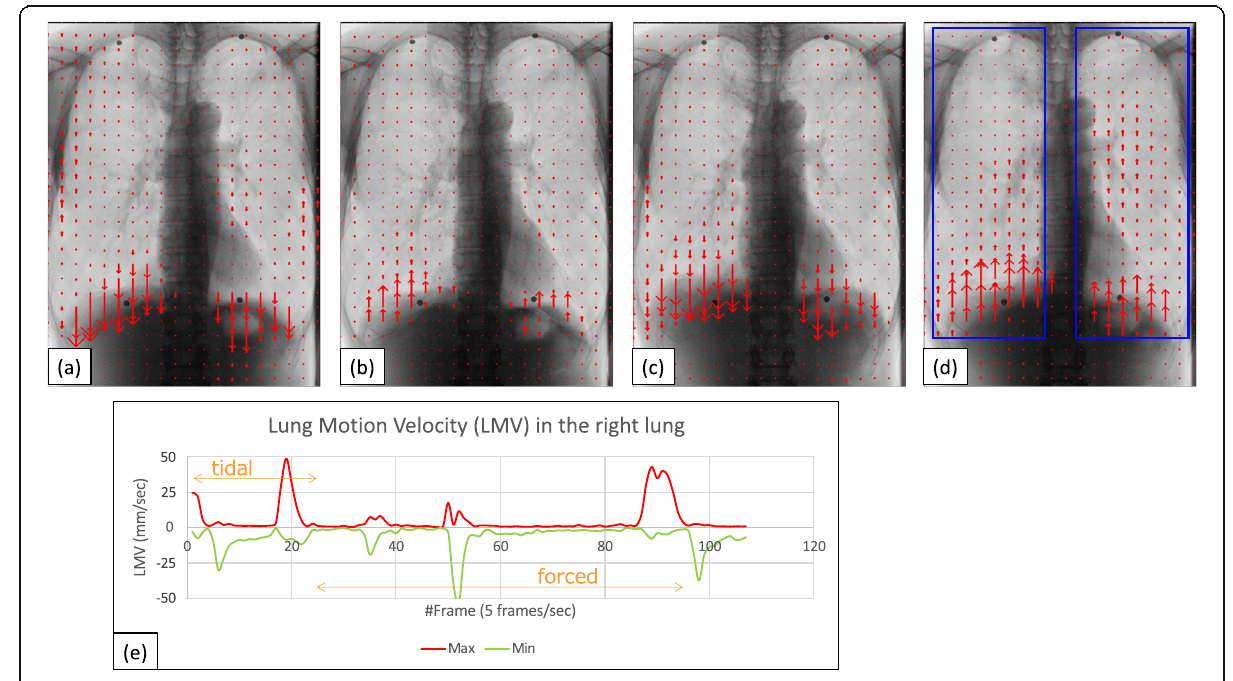
Fig. 4 A 65-year-old male, COPD patient with FEV 1 % 38.5 and %FEV 1 16.3, which meets the criteria of GOLD 4, COPD Severe group. Blue rectangles in Fig. 3 ( d ) represent bilateral ROIs. VF-DXR images in ( a ) tidal inspiratory, ( b ) tidal expiratory, ( c ) forced inspiratory, and d forced expiratory phase. Blue rectangles represent bilateral ROIs. ( e ) The graph shows the temporal change between LMV in the right lung and the number of frames. The frame rate is set to 5 frames/ s (Video 2 in the Supplemental material). COPD Chronic obstructive pulmonary disease, FEV 1 % Forced expiratory volume percent in one second divided by forced vital capacity, %FEV 1 Percent predicted forced expiratory volume in one second, GOLD Global initiative for chronic obstructive lung disease, LMV Lung motion velocity, ROI region of interest, VF-DXR Vector-field dynamic